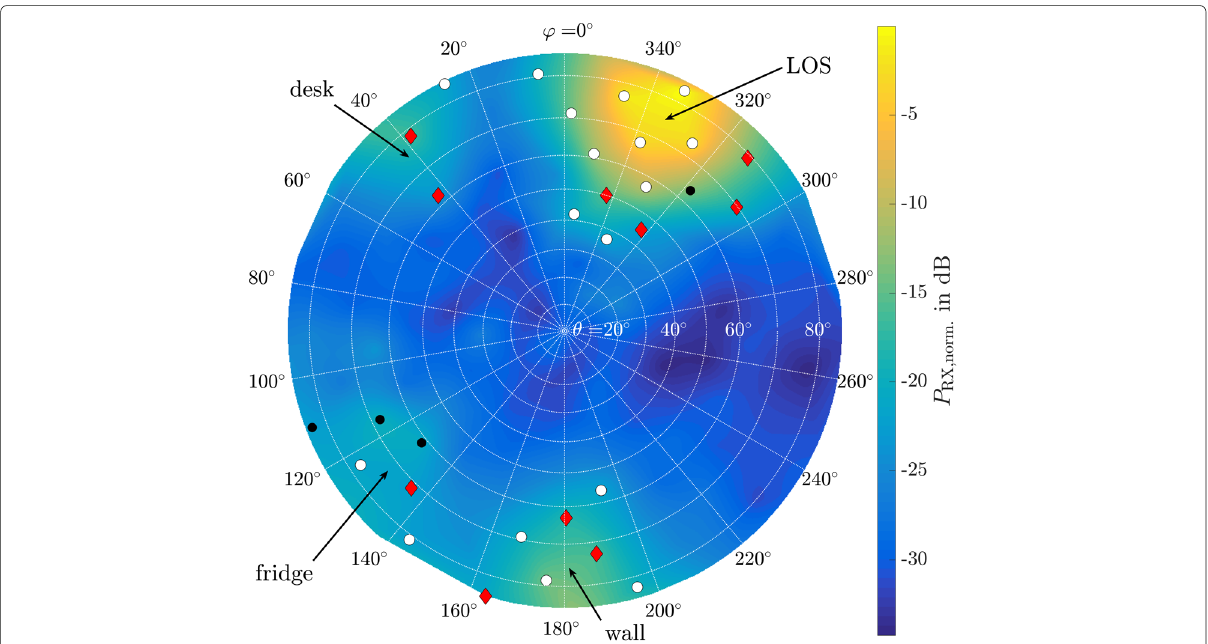
Fig. 7 Estimated directional receive power of MC1. There are four main interacting objects leading to stronger receive power (marked in the figure). TWDP fading occurs whenever the LOS-link is not perfectly aligned or the reflecting structure is not perfectly plain. Red diamonds mark TWDP fading, and white circles mark Rician fading. Black markers show points where both distributions are rejected by the hypothesis test. Directions less than 10dB above the noise level are not